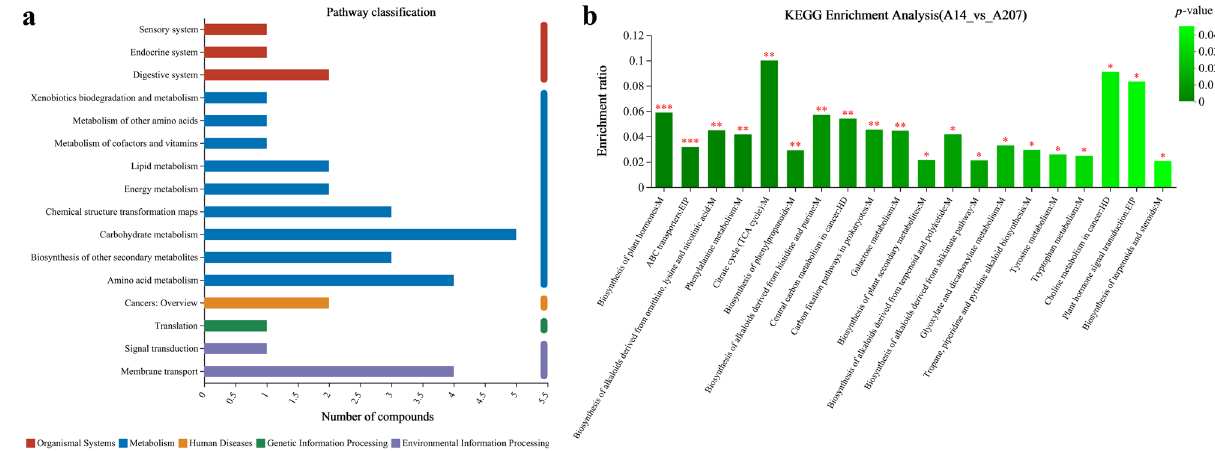
Figure 4. ( a ) Classification of differential metabolites between the A14 group and A207 group by KEGG. ( b ) The abscissa represents the pathway name. The ordinate represents the enrichment ratio, indicating the ratio of the metabolite number to the background number annotated to the pathway. The column color gradient indicates the significance of enrichment. *** indicates p < 0.001, ** indicates p < 0.01, * indicates p <